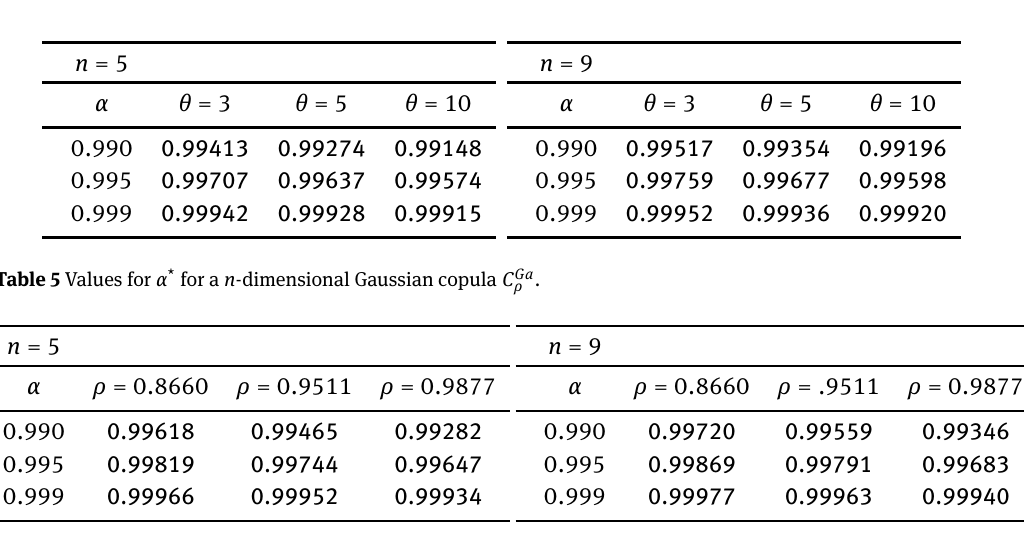
Table 4 Values for α * for a n -dimensional Gumbel copula C Gu